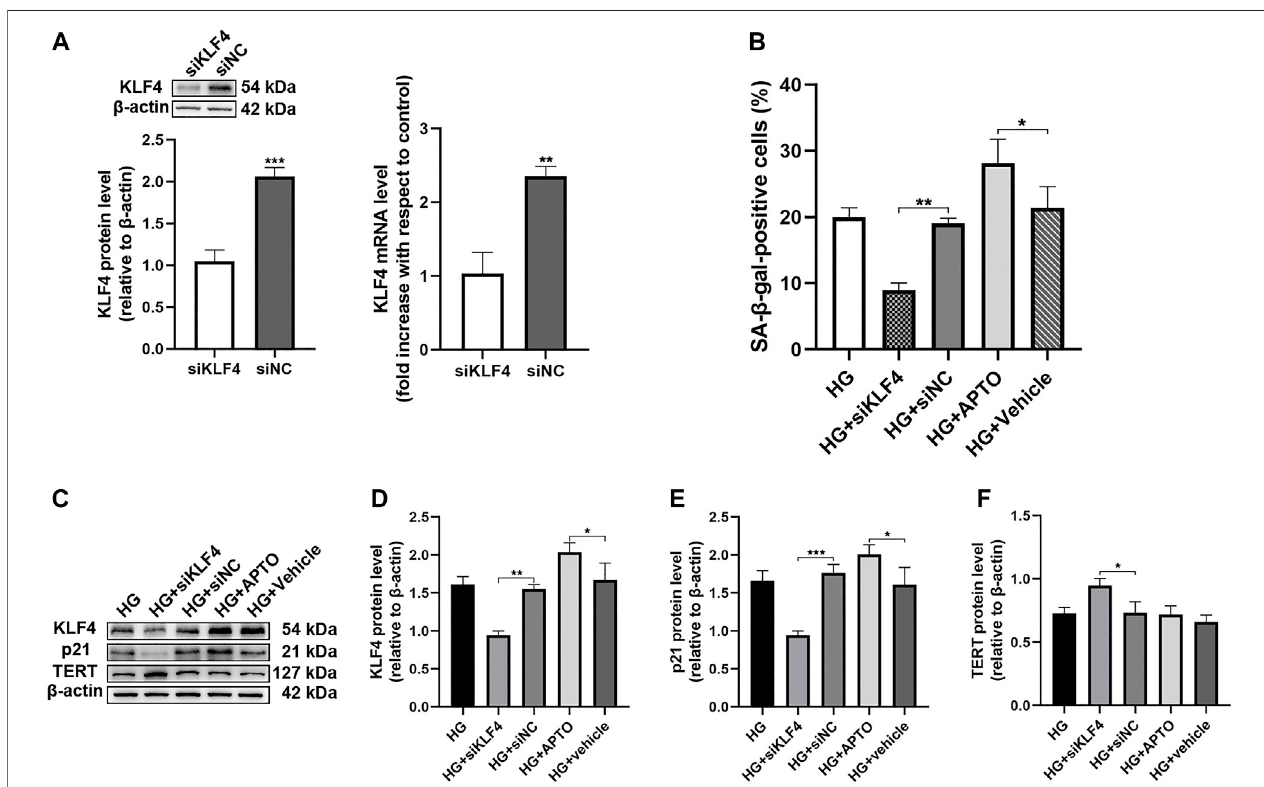
FIGURE 2 | Hyperglycemia-induced HUVEC senescence isKLF4 dependent. (A) KLF4, asmeasured by immunoblotting and qRT-PCRinHUVECsafter transfection with siNC or siKLF4 for 48 h. (B) Cells were fi xed and stained for SA- β -gal activity and the histogram represents the percentage of SA- β -gal-positive cells per microscopic fi eld. Values represent mean ± SEM. *p < 0.05, **p < 0.01. (C) KLF4, p21, and TERT protein levels were determined by immunoblotting. (D – F) Results were normalized to controls,andhistogramsrepresenttherelativeintensityofKLF4,p21,andTERT.Valuesrepresentmean ± SEM( n (cid:2) 3 – 4pergroup). *p < 0.05, **p < 0.01, ***p <